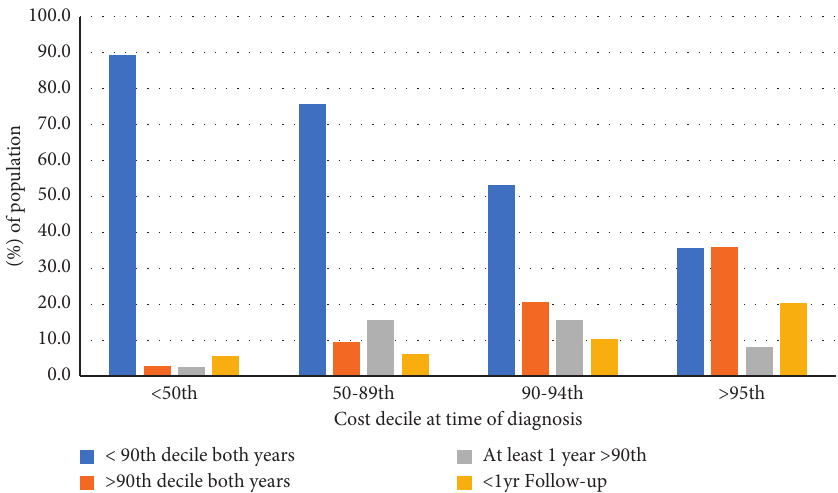
Figure 6: Total cost percentile transition patterns within 3 years of initial diagnosis in young adults with